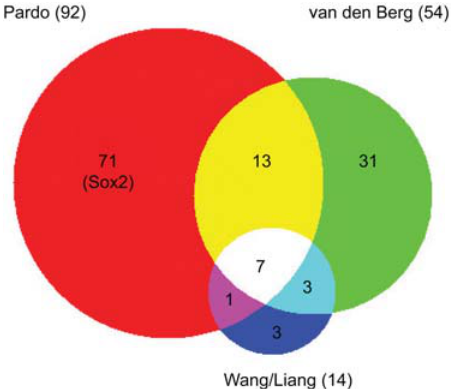
Figure 2 Venn diagram showing the number of proteins identified by protein-protein interaction with Oct4 as the bait. Proteins from the two smaller datasets by Wang et al. (39) and by Liang et al. (38) are merged into one group.